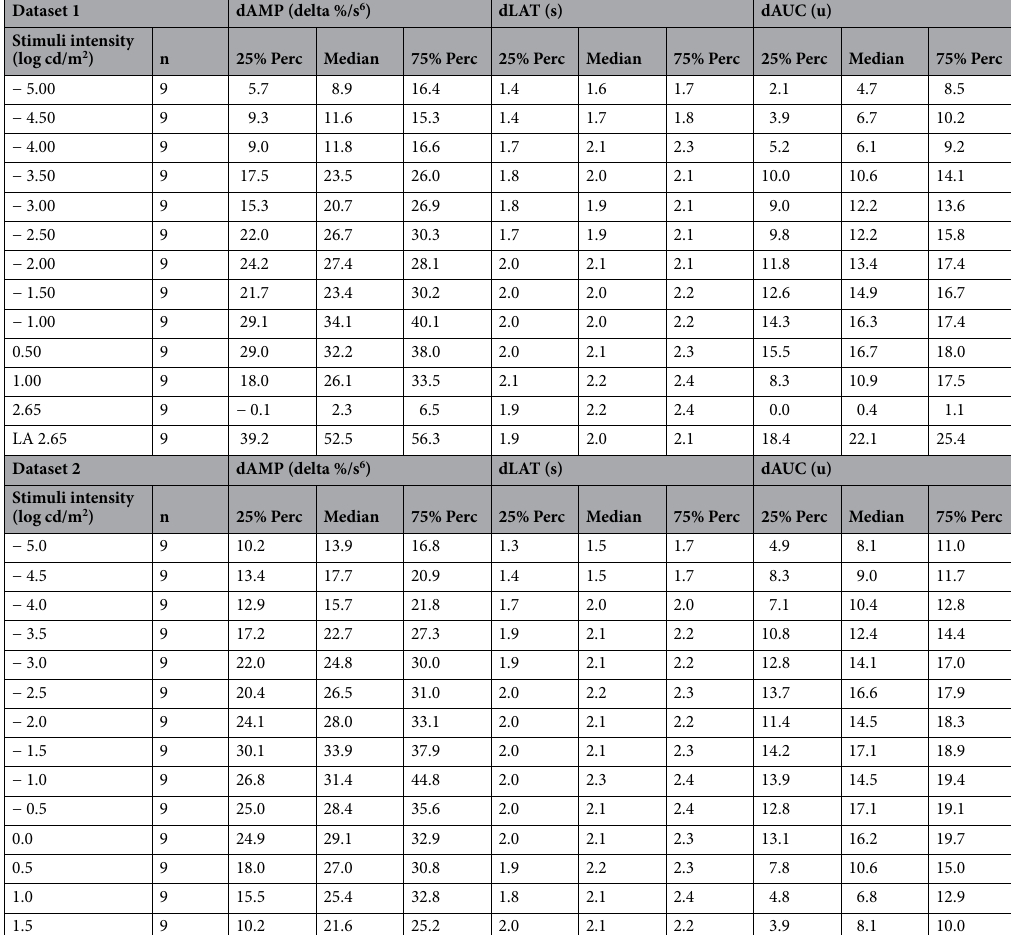
Table 1. Quantification of derivatives of normal cohorts. Median and interquartile range (25% Percentile (Perc.) and 75% Perc.) are indicated for dAMP, dLAT and dAUC of Dataset 1 and Dataset